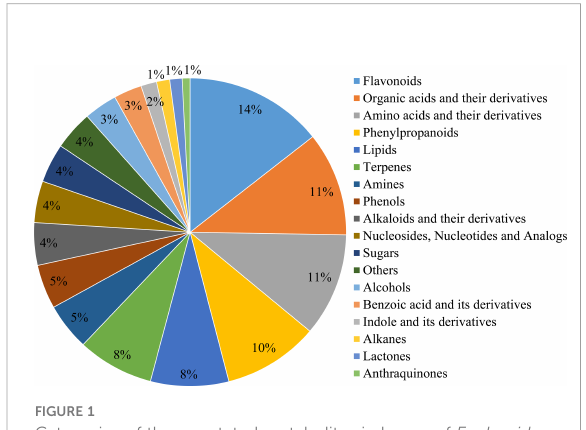
FIGURE 1 Categories of the annotated metabolites in leaves of E. ulmoides